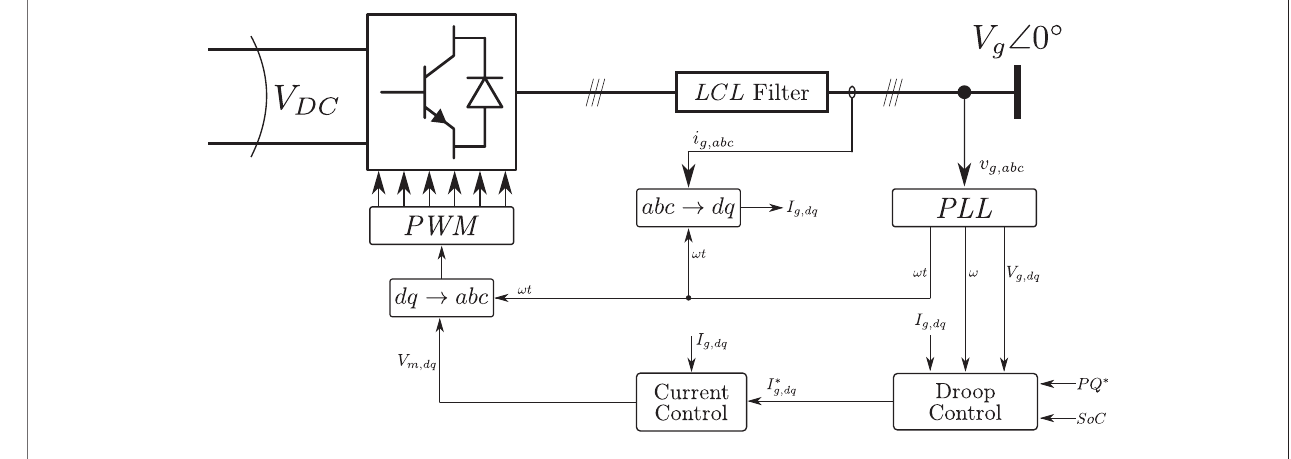
FIGURE 5 | Simpli fi ed scheme of Grid-support converter.